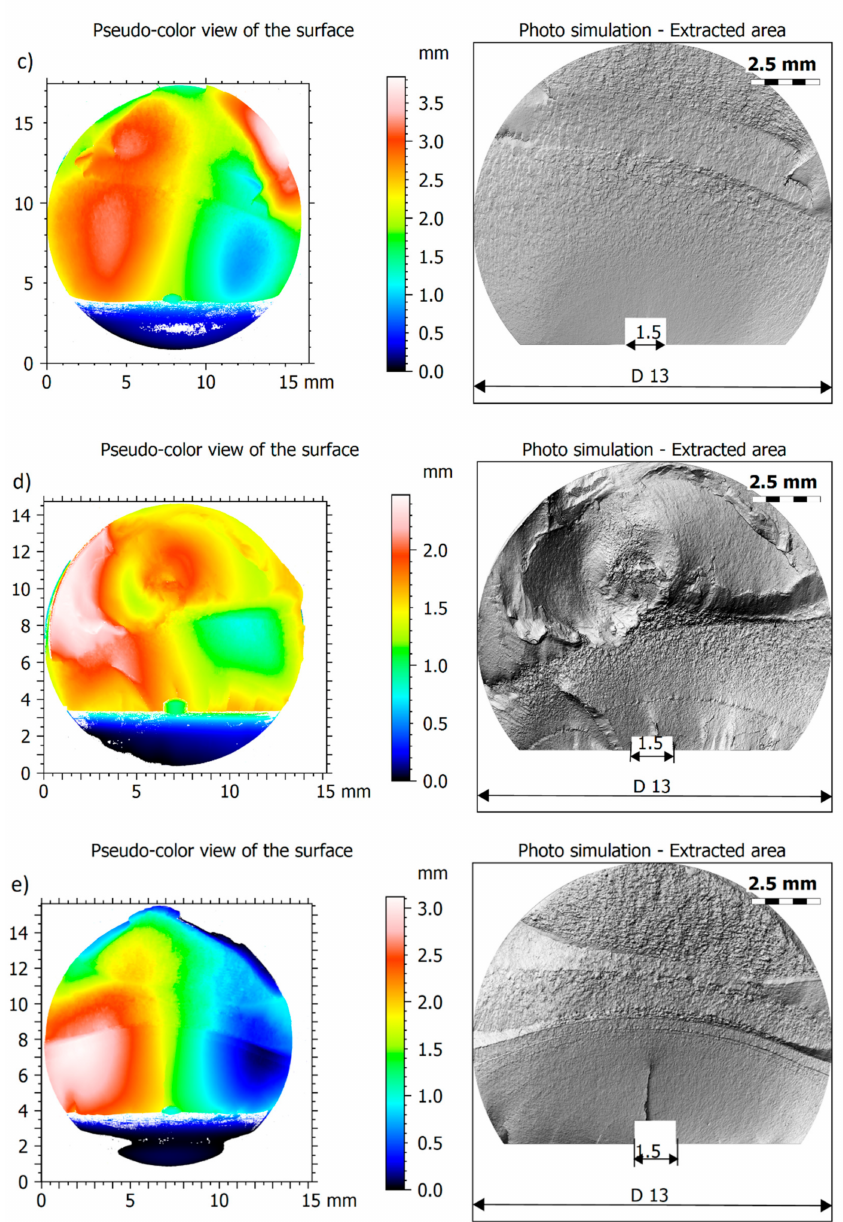
Figure 2. Original and extracted fracture surfaces: ( a ) BT1-2; ( b ) BT1-3; ( c ) BT2-1; ( d ) BT2-2; ( e ) BT2-3. Figure 3 presents a summary of results of the fracture surface measurements, as a scatter plot, for the different tested specimens. It is clearly seen that all values of both Sx and Vx are higher for B/T = 1 ( σ / τ = 2) than for B/T = 2 ( σ / τ = 4). A similar tendency can be noticed for the fractal dimension, Df , determined by the EBM described above. However, its values show greater differentiation and dispersion at B/T =